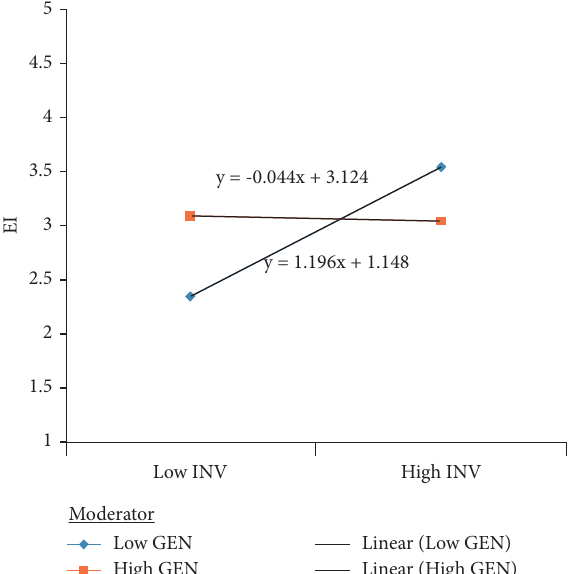
Figure 3: (Graphical presentation of moderation effect of GEN on INV). GEN diminishes the positive relationship between INV and